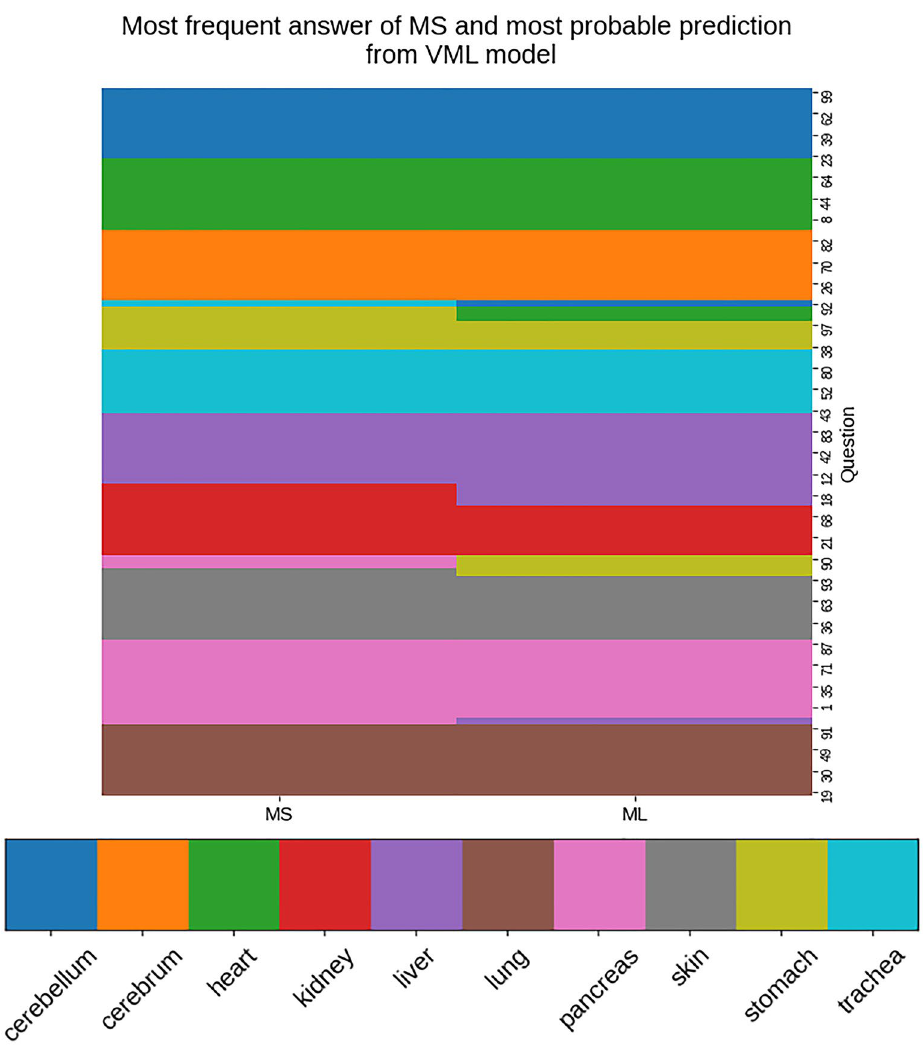
Figure 10. Clustered heatmap showing commonest responses by MS, and predictions with highest probability from VML, on each individual image of the quiz set (n = 100); 90% match is noted (Figure generated by Matplotlib python library, version 3.3.4, https:// matpl otlib.